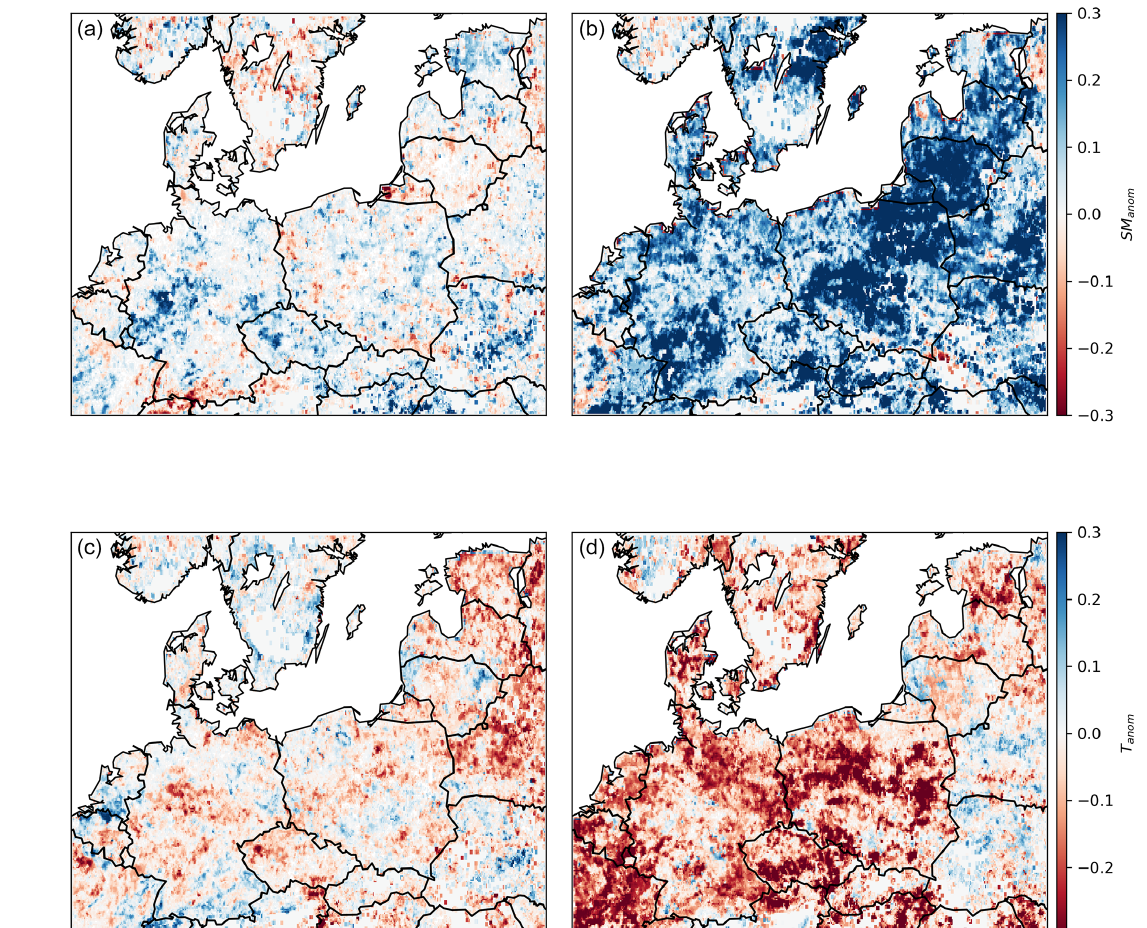
Figure B5. Importance of the four predictors used in the RF model to predict EVI anom in spring (a, c) and summer (b, d) , SM anom (a, b) , and T anom (c, d) calculated from the Shapley additive explanation values.